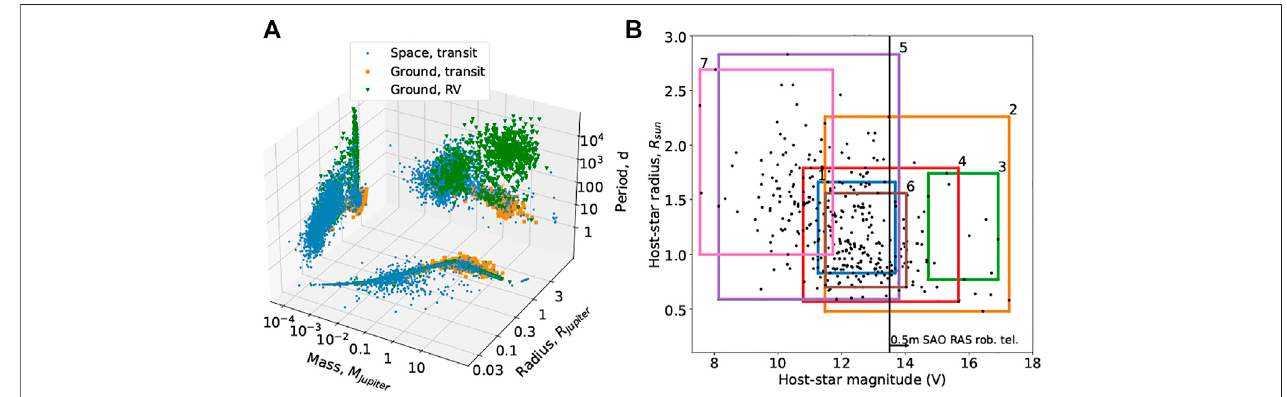
FIGURE 2 | Statistics on the number of images per night: (A) distribution by time with the colored columns marking the nights with successfully performed photometry and (B) distribution by number.